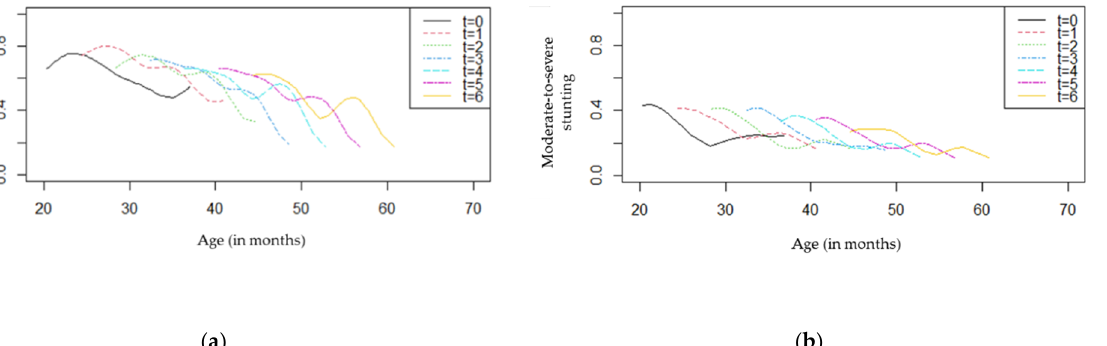
Figure 6. Stunting profiles by age and follow-up ( t = 0,1,2,3,4,5,6): ( a ) mild-to-severe stunting; ( b ) moderate-to-severe stunting.